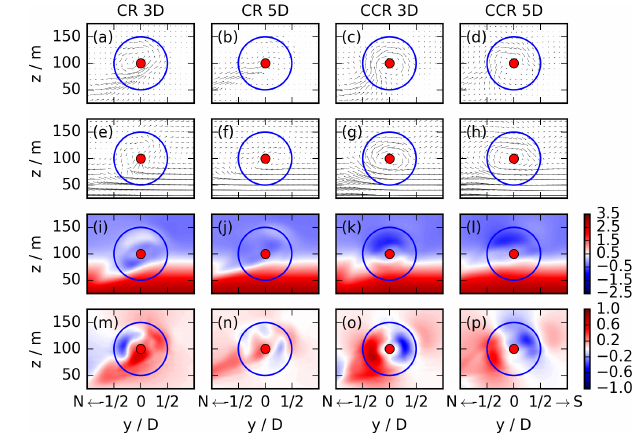
Figure 6. y – z cross sections of the SBL wind-turbine simulations for CR and CCR at x =3D and 5D. The first row (a–d) presents the ( v , w ) vectors as the difference between the vector at x = 3D (or 5D) and the inflow region, the second row (e–h) the velocity vector in the y – z plane, the third row (i–l) the meridional wake velocity v , and the fourth row (m–p) the vertical wake velocity w . The blue contour represents the circumference of the actuator. The stream- wise flow is from the west, and these cross sections correspond to a view towards the east downwind through the turbine with north on the left and south on the